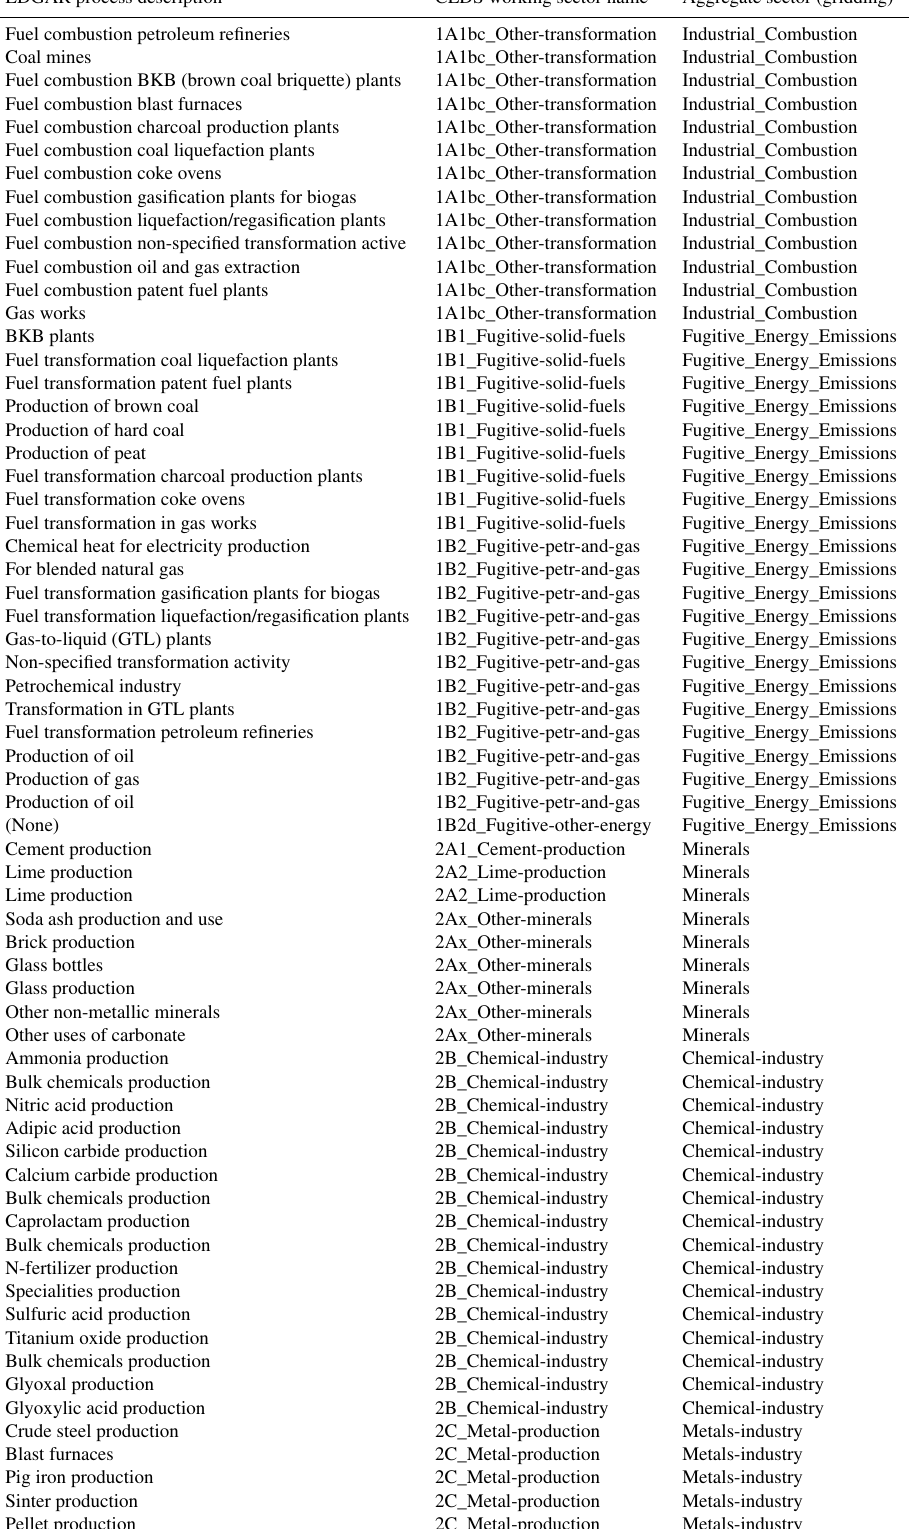
Table A2. Sector definitions of non-combustion emissions (drawn from EDGAR processes). EDGAR process